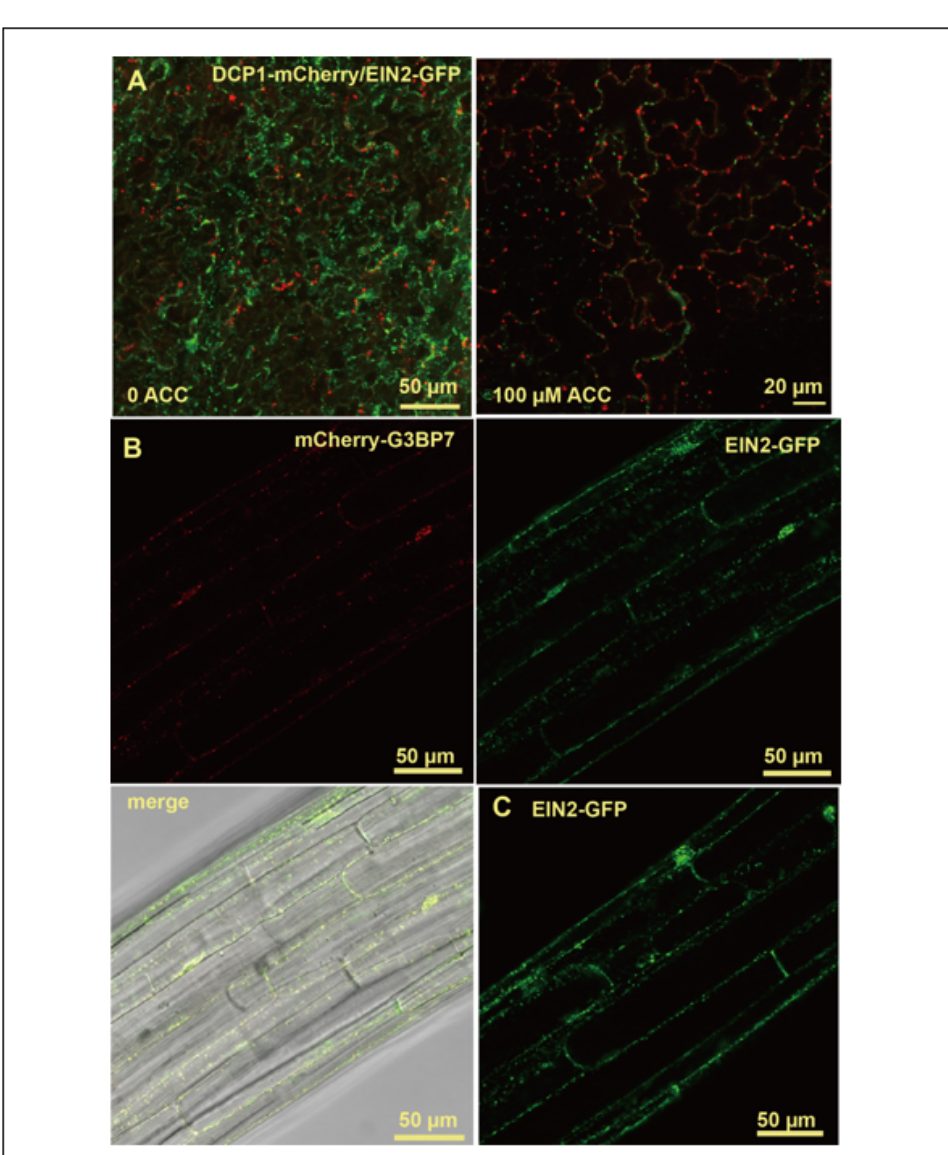
Figure 2. Molecular experimental studies on the involvement of EIN2 in LLPS. Subcellular local- izations of EIN2-GFP with LLPS markers. ( A ) Fluorescence of EIN2-GFP (green) and PB marker DCP1-mCherry (red), without (0 ACC) and with ACC (100 μ M) treatment. ( B ) Fluorescence of the SG marker mCherry-G3BP1 (red) and EIN2-GFP (green) upon a 42 °C stress induction. ( C ) The EIN2-GFP granule formation was independent of the SG marker upon the heat induction. The images were acquired from leaf ( A ) and seedling hypocotyl ( B , C ) cells of Arabidopsis transgenic lines expressing transgenes encoding the indicated proteins.